Question: Identify the chart type used in this figure.
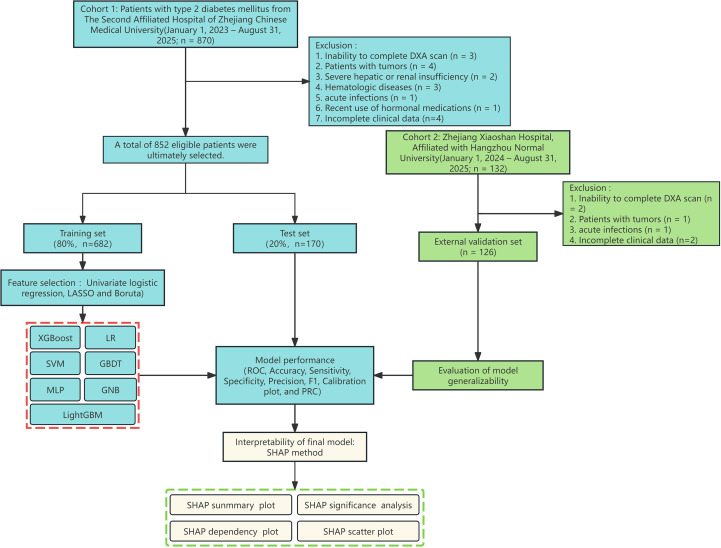
Answer: line